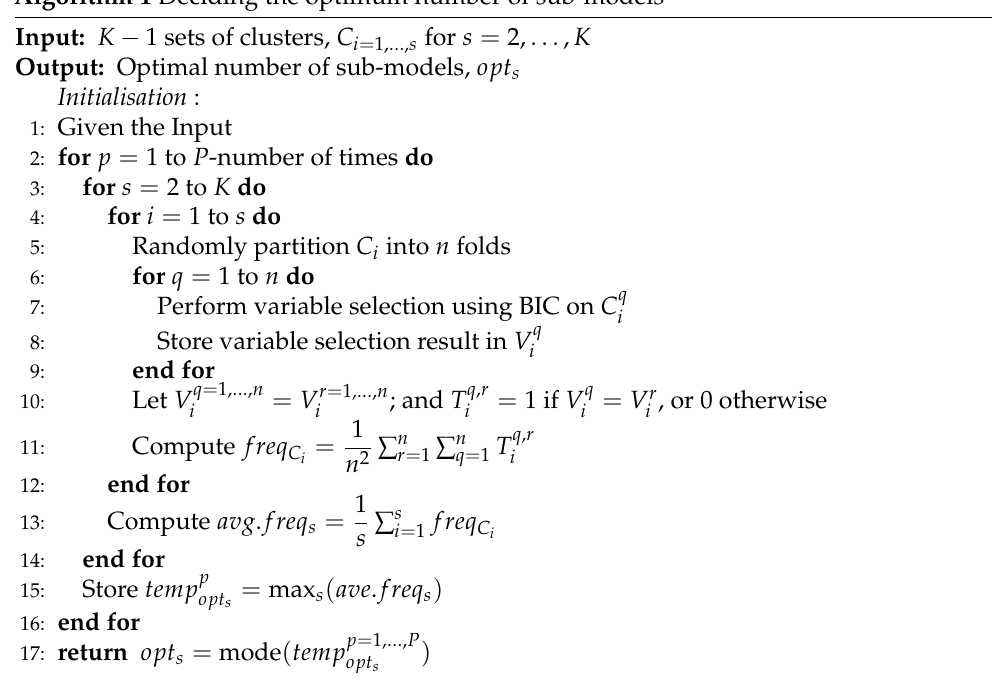
Algorithm 1 Deciding the optimum number of